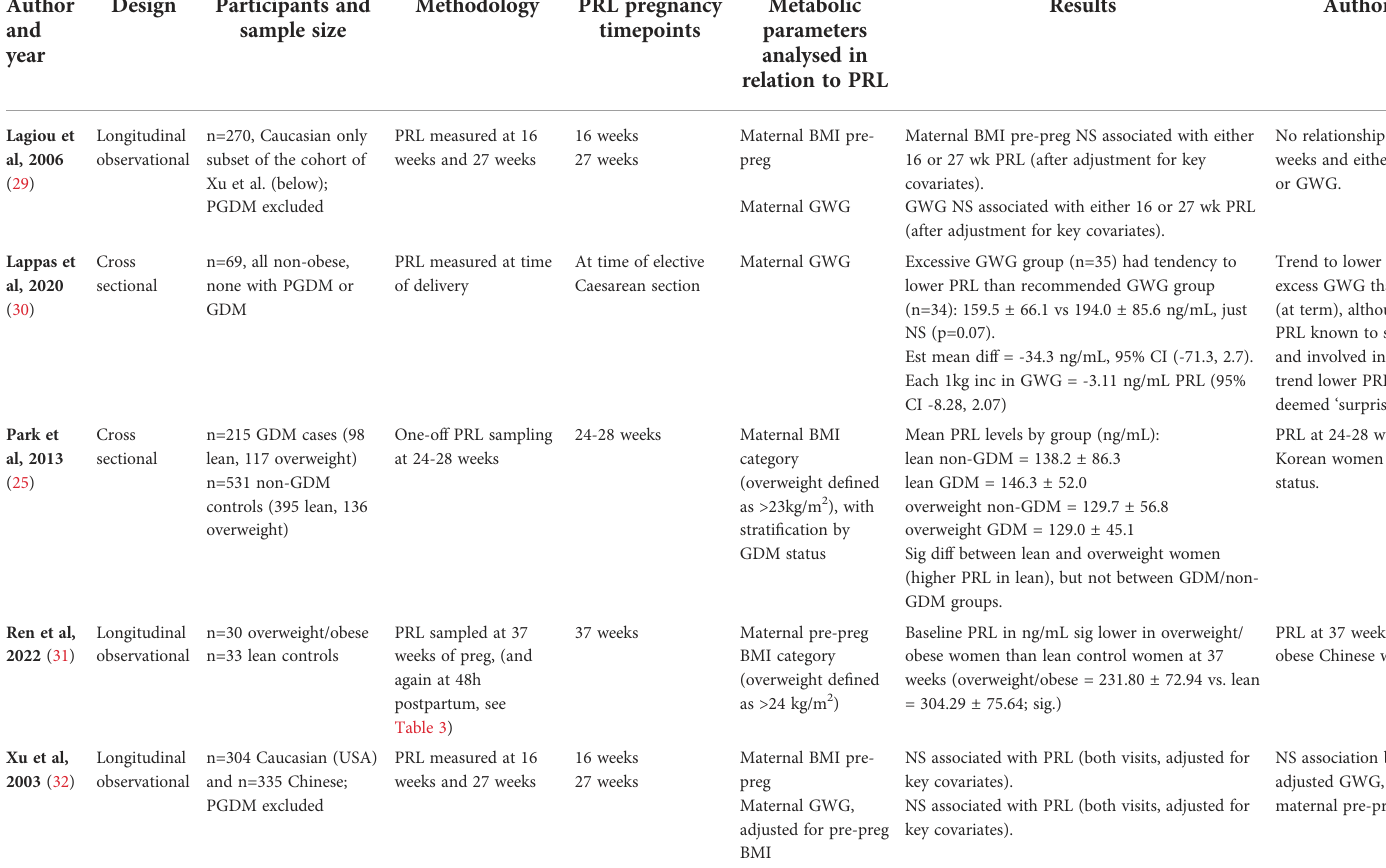
TABLE 2 Studies examining PRL in relation to maternal BMI and/or gestational weight gain – 5